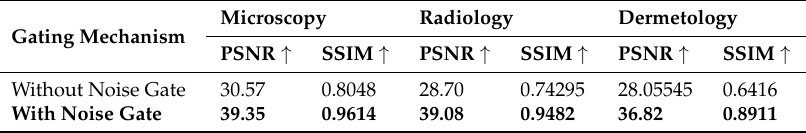
Table 3. Impact of noise gate in network performance. It can be seen that the noise gate drastically improves the performance of the proposed method compared to its